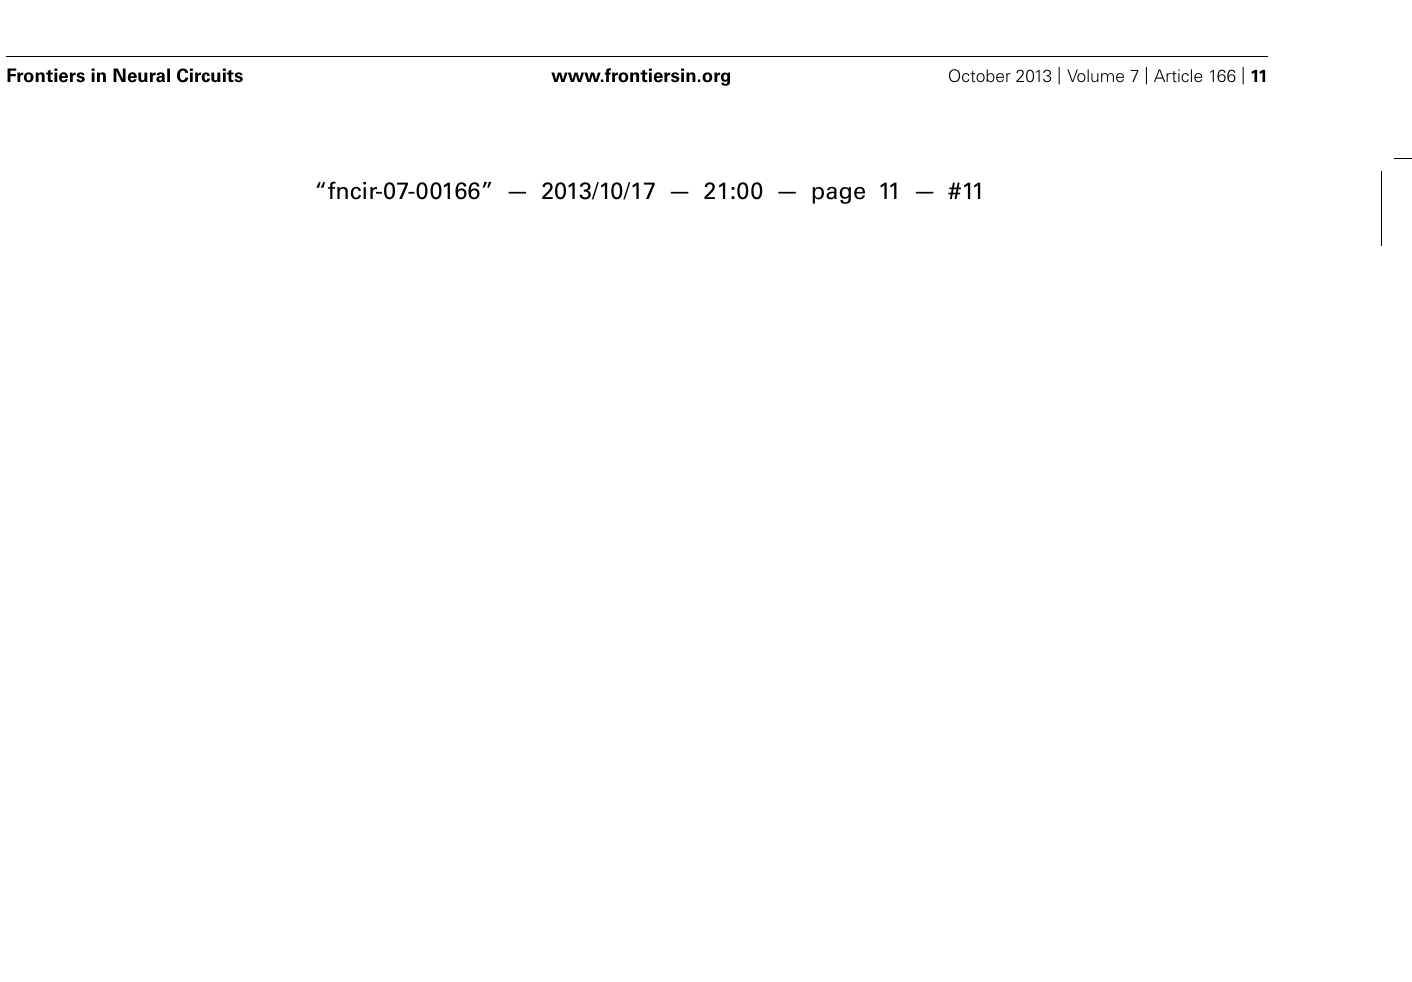
transform. (C) Spectrogram made from the frequency-specific envelopes outputted from the DRNL model. Each row of the plot is an envelope outputted from one discrete DRNL frequency channel. Note that the different frequency channels of the DRNL model overlap in frequency ranges and thus smear the spectrogram plot in the frequency dimension. (D) Neural representation of the spectrotemporal features of activity recorded across all 203 sites. Each row is a PSTH recorded from each ICC site for a specific best frequency region. dB FS decibels relative to full scale in which 0 dB FS corresponds to the maximum